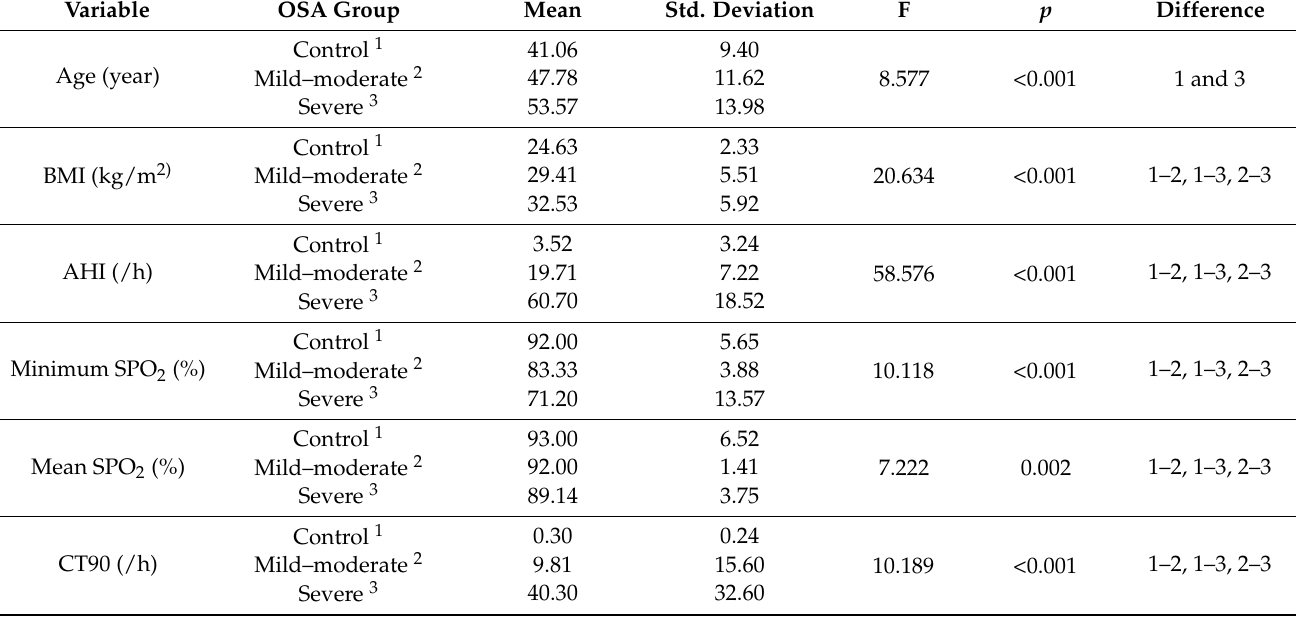
Table 1. Evaluation of basic demographic and polysomnographic